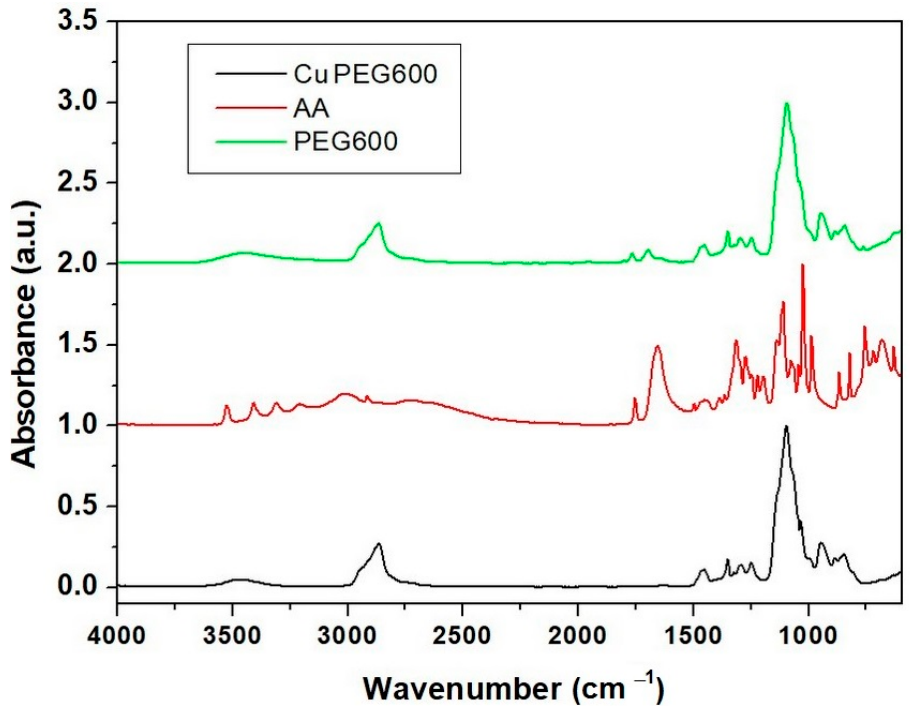
Figure 4. FT-IR spectra of copper clusters, ascorbic acid, and PEG 600.